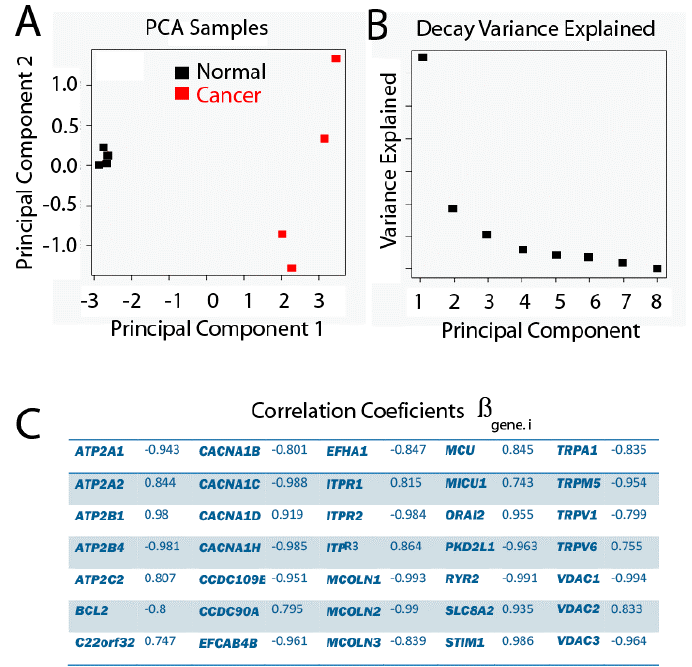
Figure 6. Principal Component Analysis (PCA), where genes are variables and samples are observations. The proportion of variance explained by PC1 is equal to 59.82%, and 16.19% for PC2. ( A ) PC2 vs. PC1; ( B ) Decay Variance Explained graph; ( C ) Correlation coefficients.